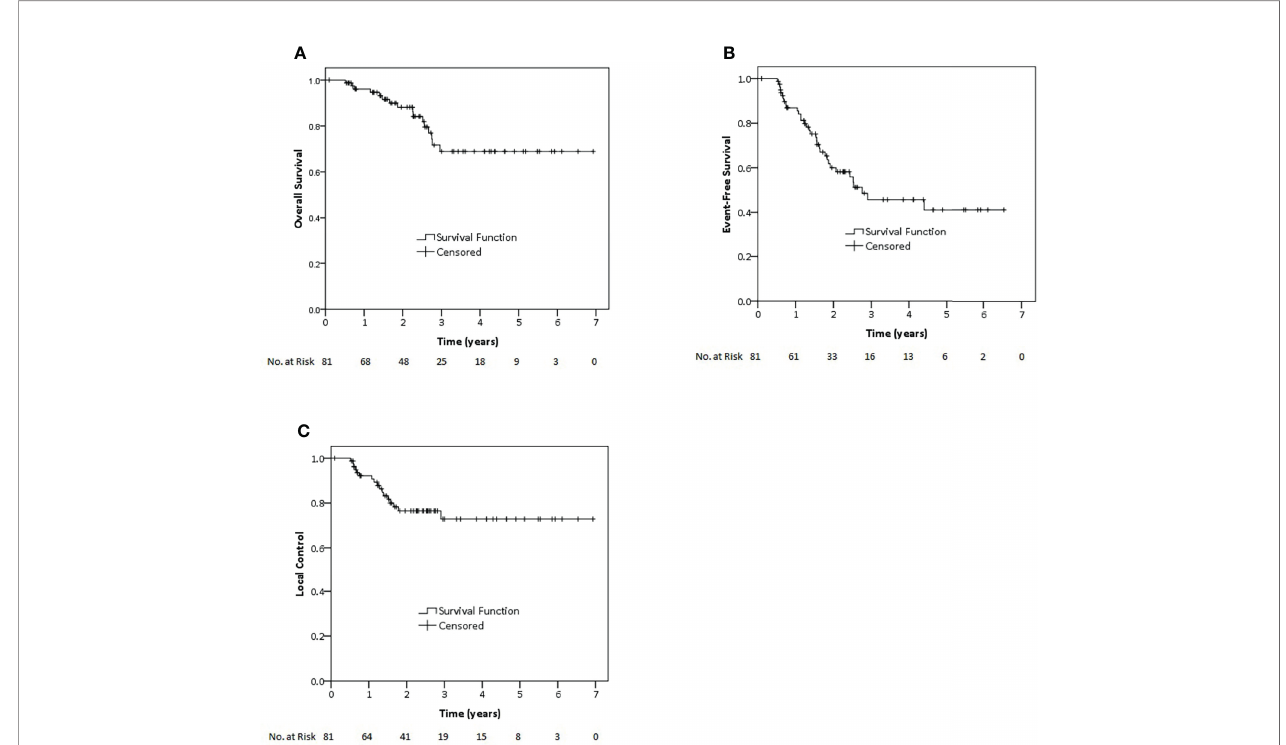
FIGURE 1 | Kaplan – Meier estimates of overall survival (A) , event-free survival (B) and local control (C) rates for all patients of this